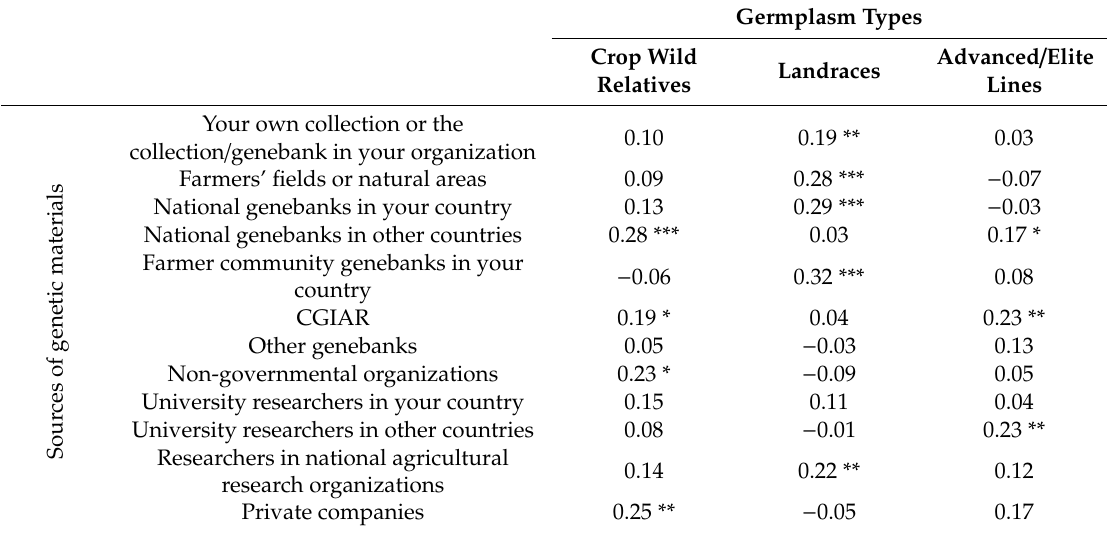
Table 5. Association between changing material types and sources of breeding